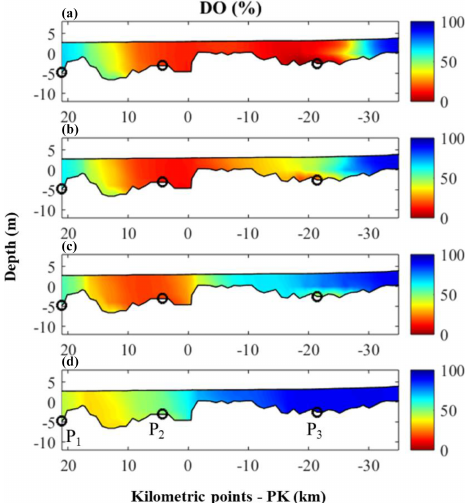
Figure 4. Snapshot of the vertical transect of simulated DO concen- tration (in % saturation) along the tidal Garonne river for the scenar- ios of reference (a) and short river flow increases by 100m 3 s − 1 (b) , 200m 3 s − 1 (c) and 400m 3 s − 1 (d) . P1, P2 and P3 indicate the lo- cations of Bec d’Ambès, Bordeaux and Portets,